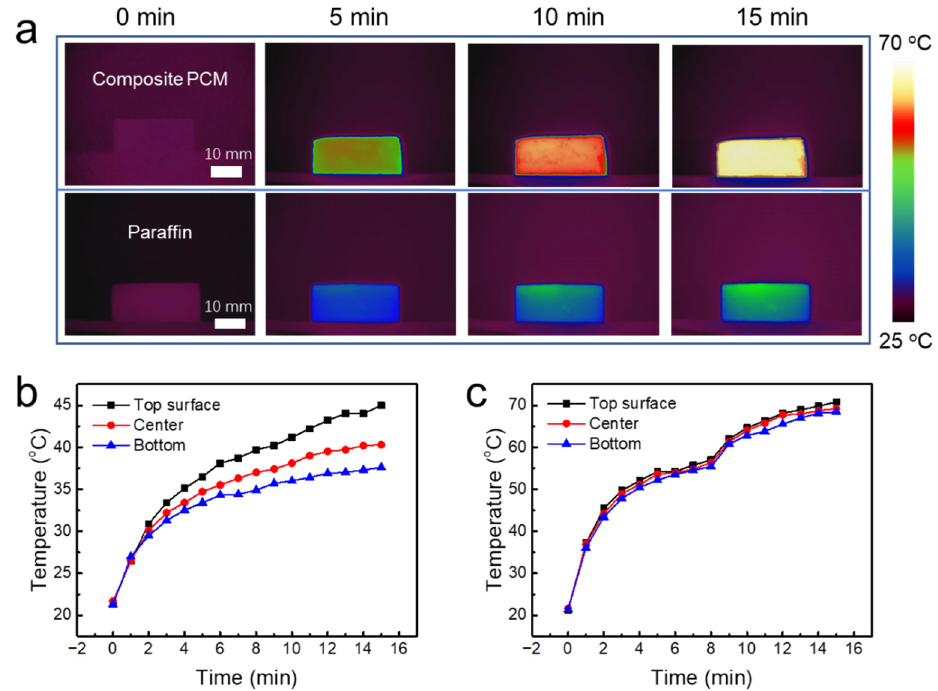
Figure 4. Thermal performance of the PCMs in the charging process. ( a ) IR images of the pure paraffin sample and the composite PCM sample at different charging time. ( b , c ) Temperature evolutions of the pure paraffin sample ( b ) and the composite PCM sample ( c ).